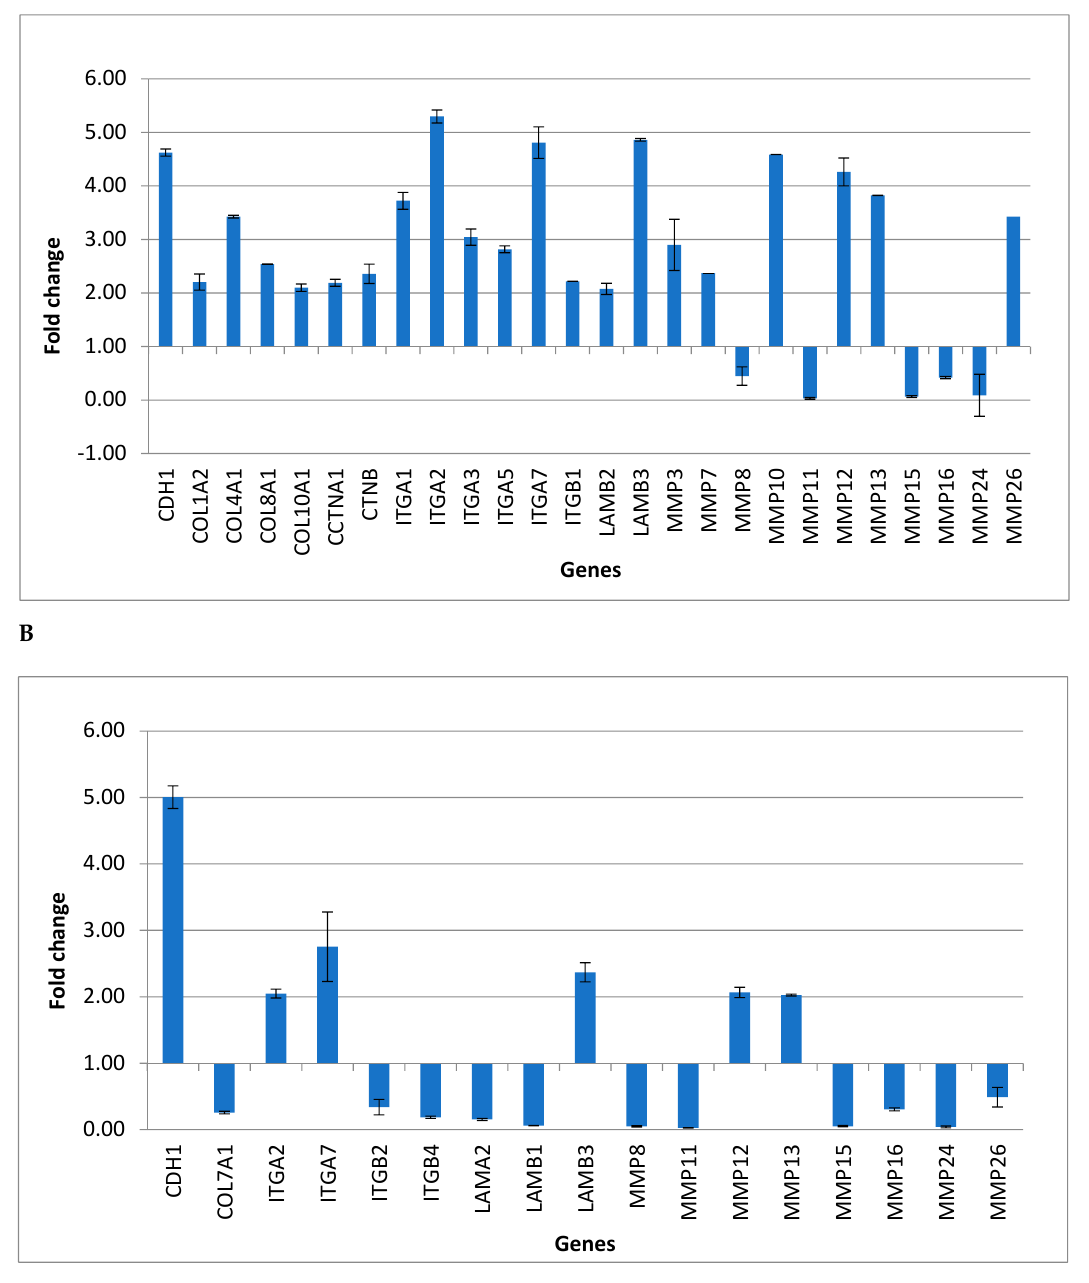
Figure 1. Significant expression levels of the genes up- and downregulated in fibroblast cells treated with mycophenolate ( A ) and cyclosporine ( B ) [34]. Table 3. Significant gene expression levels after 24 h of treatment with mycophenolate, as compared 5 with untreated cells. 6